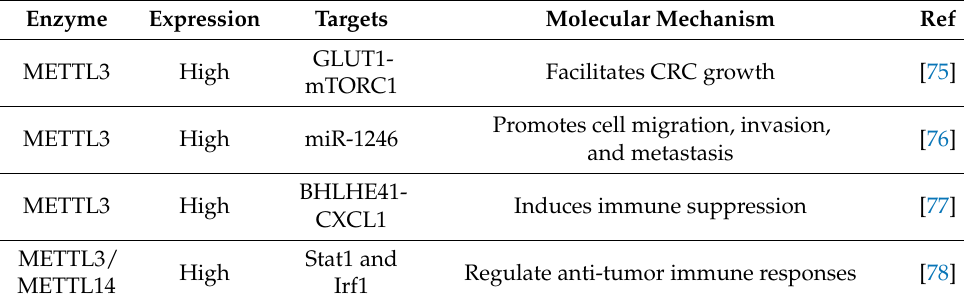
Table 2. RNA modification and colorectal